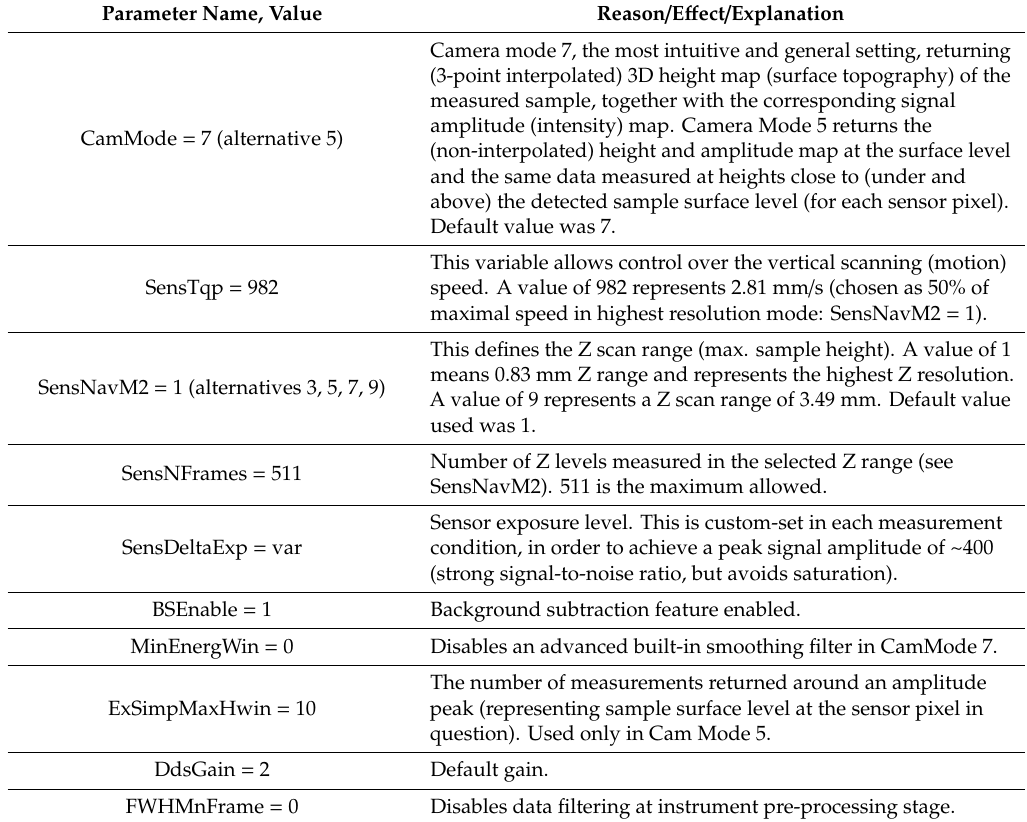
Table 1. H6 instrument settings used. All other settings left at factory